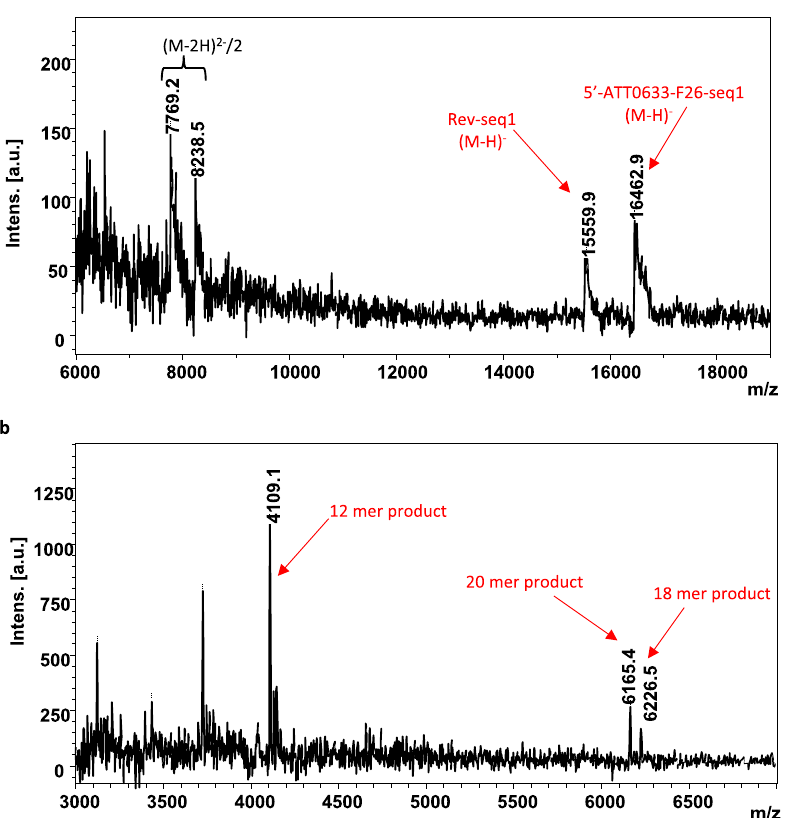
Fig. 3 MALDI-ToF mass spectra of the drUvrABC incision-reaction substrates and products. The incision reactions were performed at 37 °C for 1 hour using 25 nM F26-seq1 substrate, 1 µ M drUvrA1, 0.5 µ M drUvrB and 2 µ M drUvrC, 2.5 mM MgCl 2 , and 2.5 mM ATP. Peaks corresponding to either substrates ( a ) or products ( b ) of the incision reaction are indicated with red arrows. Masses of major peaks are indicated in Da. In ( a ), the two peaks with m/z values close to 8000 correspond to the doubly charged forms of the starting oligonucleotides bearing the lesion (5 ′ -ATTO633-F26-seq1) and its complementary strand